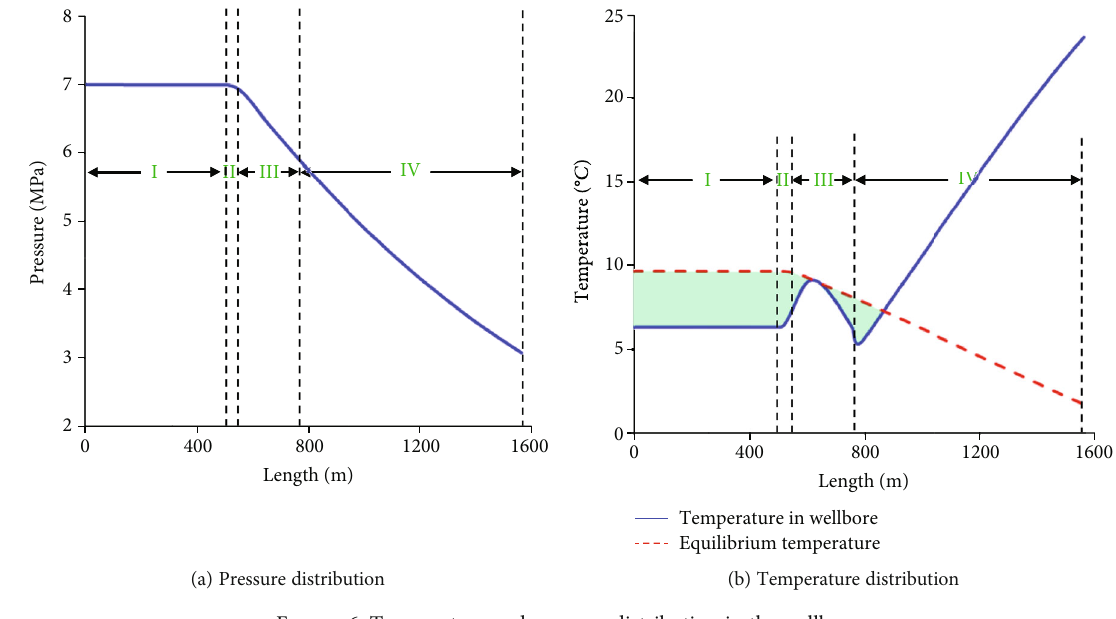
Figure 6: Temperature and pressure distribution in the wellbore.